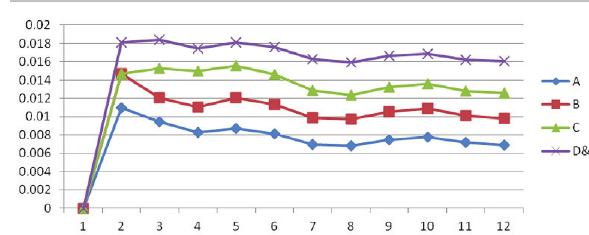
Figure 8g. Accumulated impulse response of PPI to shocks in the number of HOS flats transacted